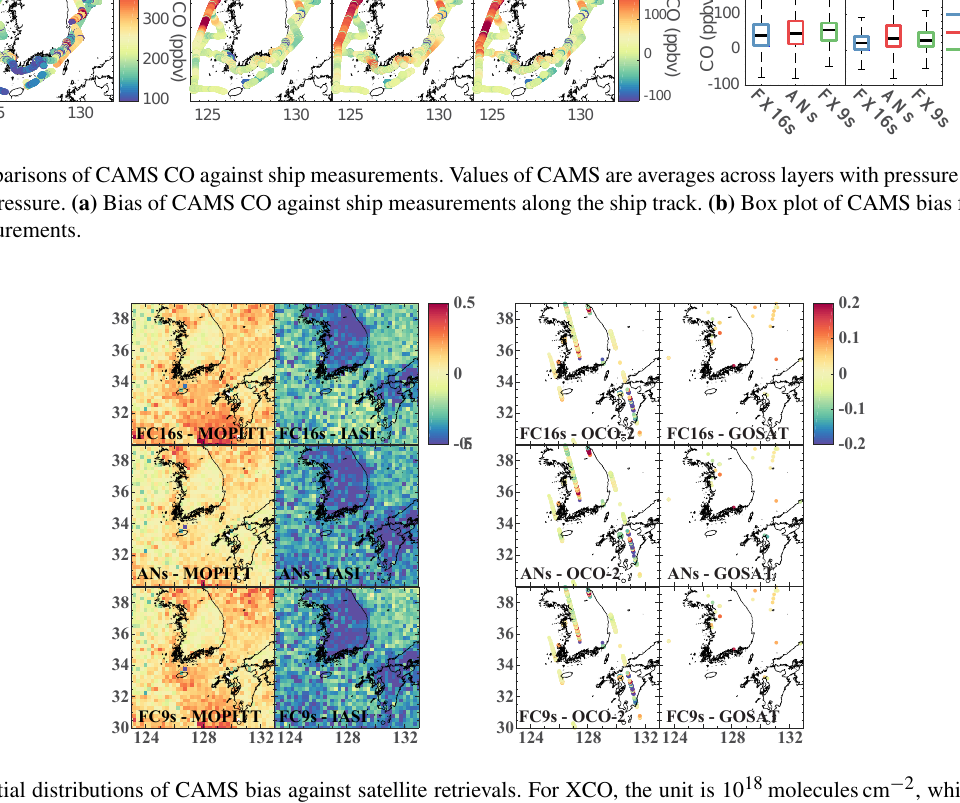
Figure 10. Spatial distributions of CAMS bias against satellite retrievals. For XCO, the unit is 10 18 moleculescm − 2 , while for XCO 2 , the unit is 10 21 moleculescm − 2